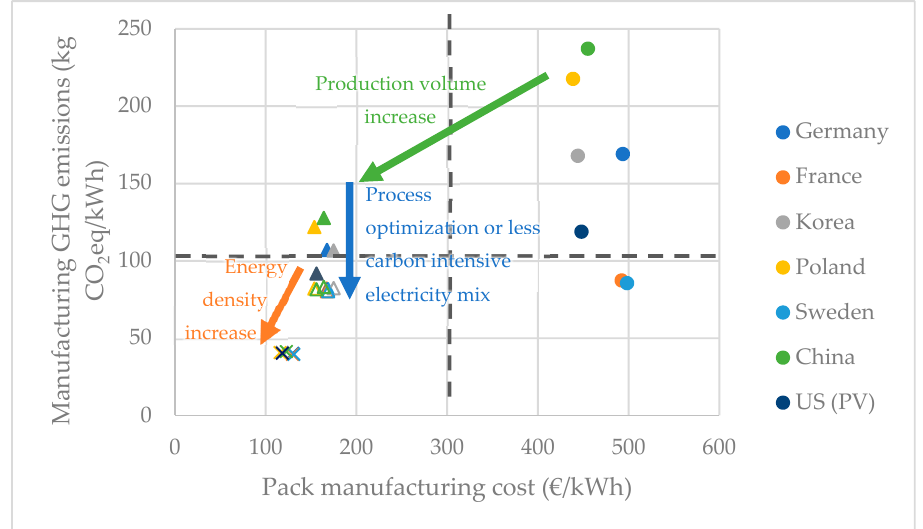
Figure 8. Manufacturing eco-efficiency of a NCA battery pack for electric vehicles (EVs) (circles are for small production volume, triangles are for high production volume, empty symbols are for minimum energy consumption, crosses are for high production volume with a minimum energy consumption and a higher energy density).